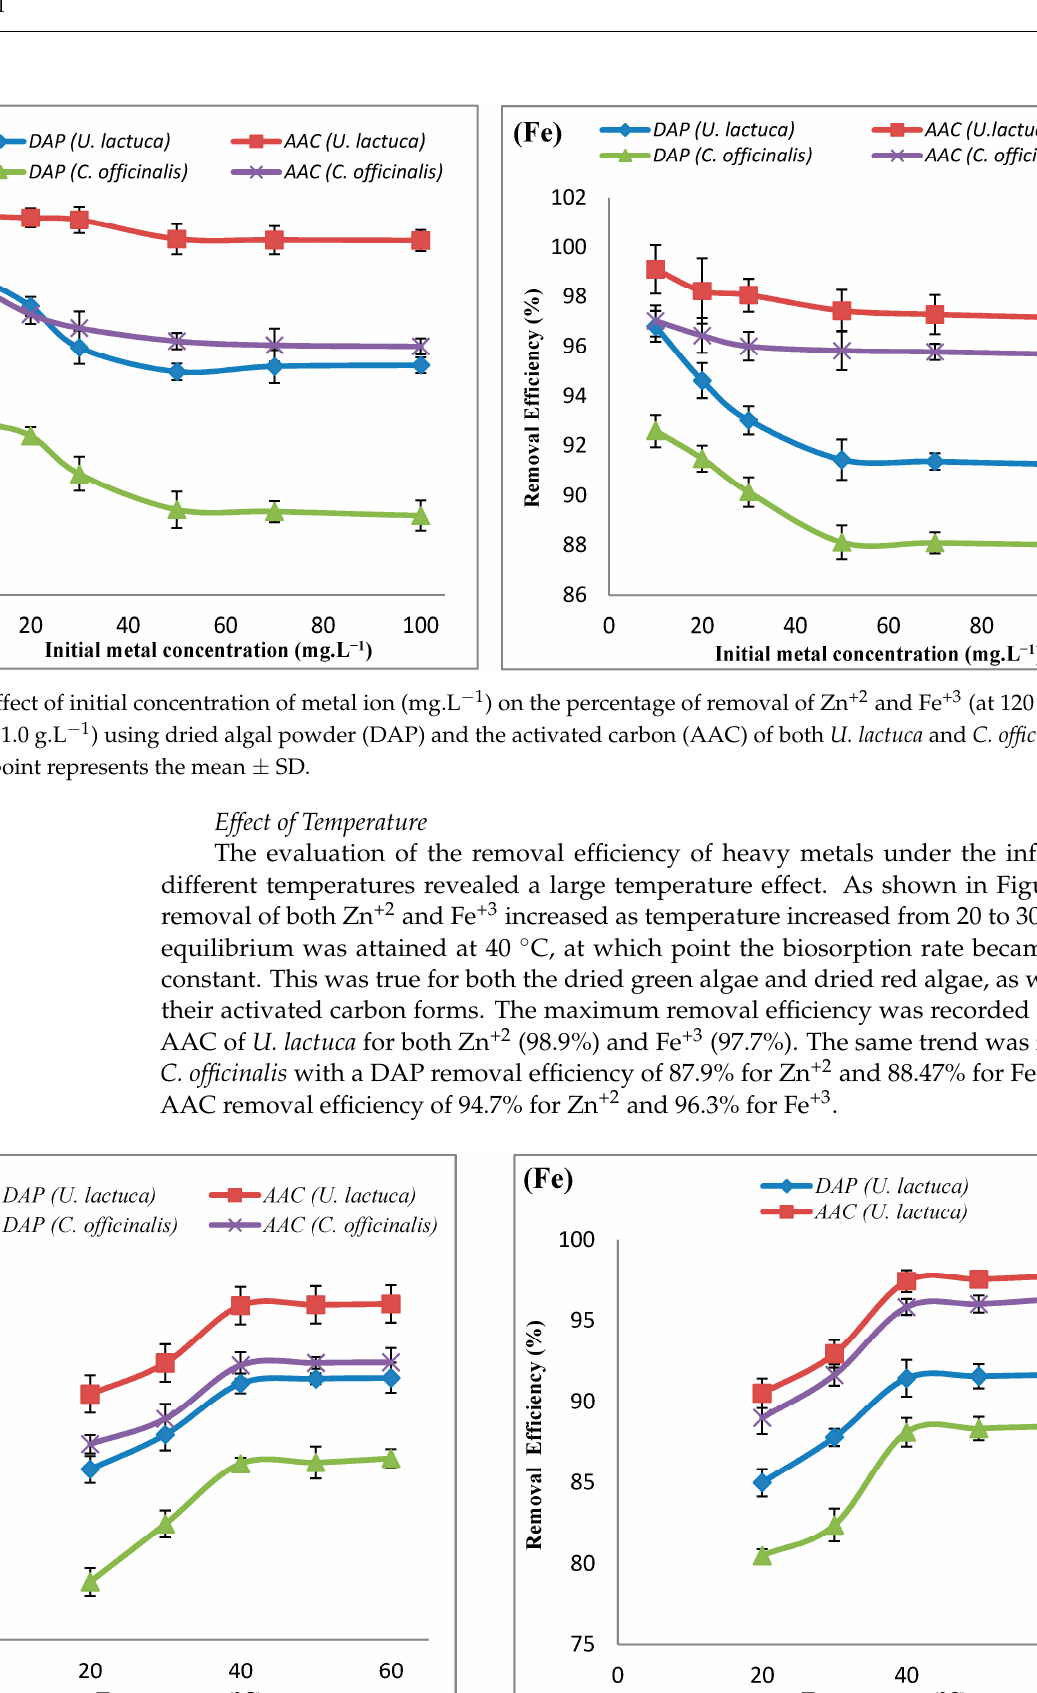
Figure 6. Plot of ln k d versus 1/T for adsorption of Zn +2 and Fe +3 ions (50 mg.L − 1 ) on DAP and AAC of both U. lactuca and C. officinalis (1g.L − 1 ). Each data point represents the mean ± SD.